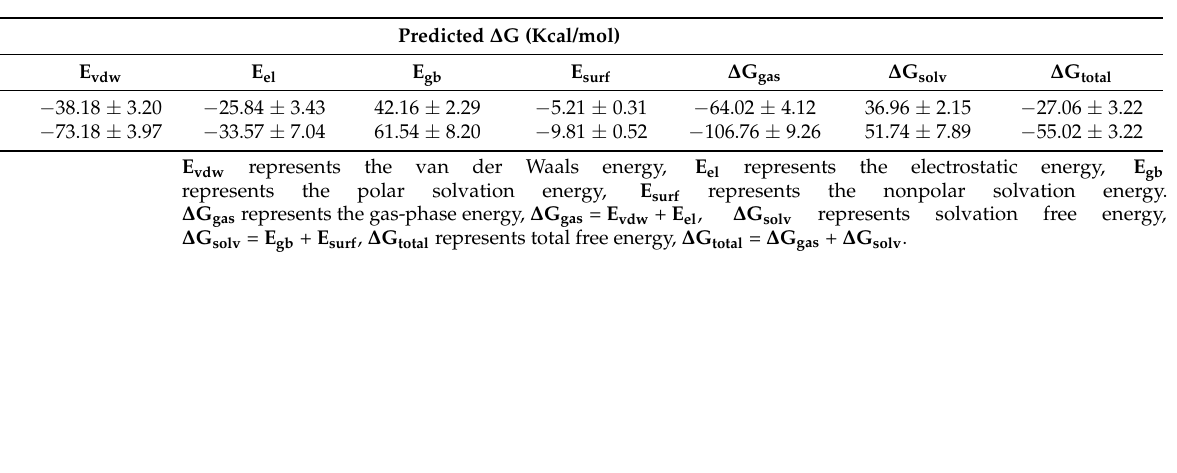
Table 2. Binding free energy of AKT with curcumin or B5 calculated by MM-GBSA. Predicted Δ G (Kcal/mol) Compound